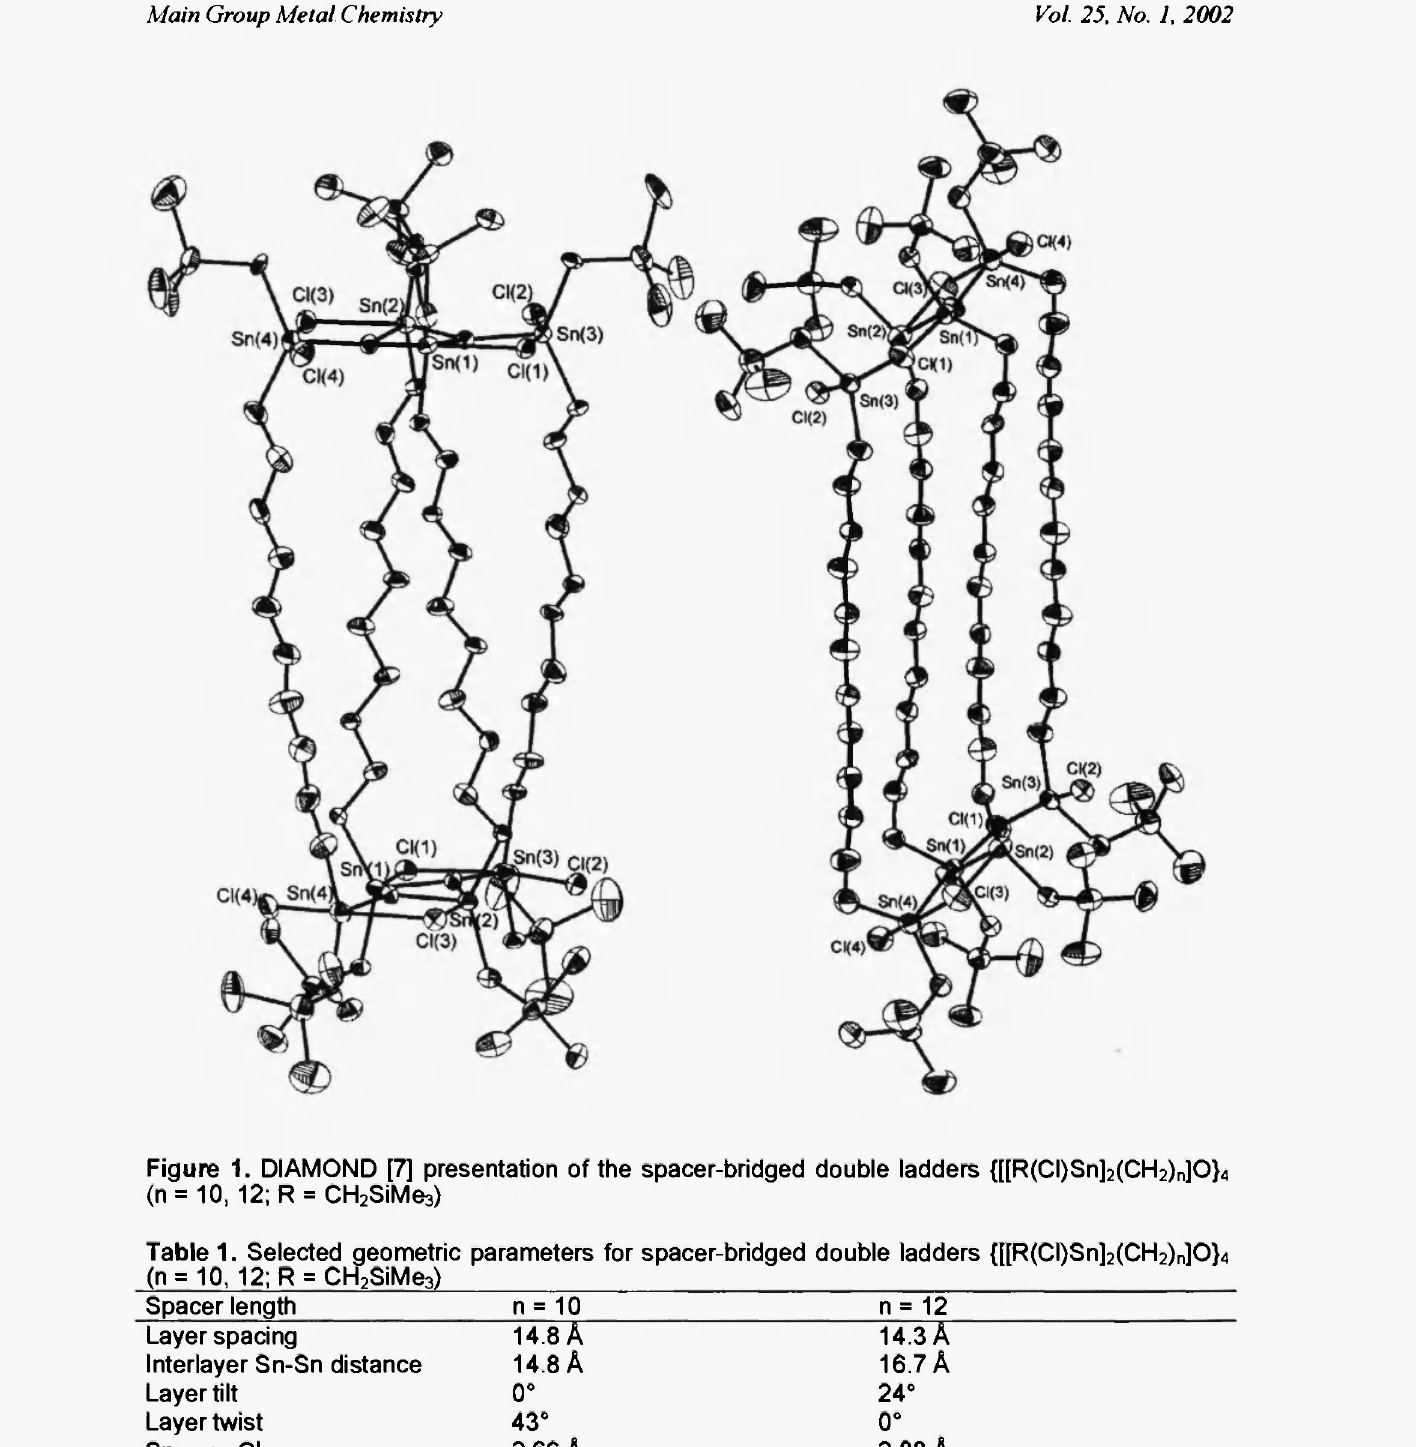
Figure 1. DIAMOND [7] presentation of the spacer-bridged double ladders {[[R(CI)Sn] 2 (CH 2 ) n ]0} 4 (n = 10, 12; R = CH SiMe3) 2 Table 1 . Selected geometric parameters for spacer-bridged double ladders {[[R(CI)Sn] 2 (CH 2 ) n ]0 }4 (n = 10, 12; R = CH 2 SiMe 3